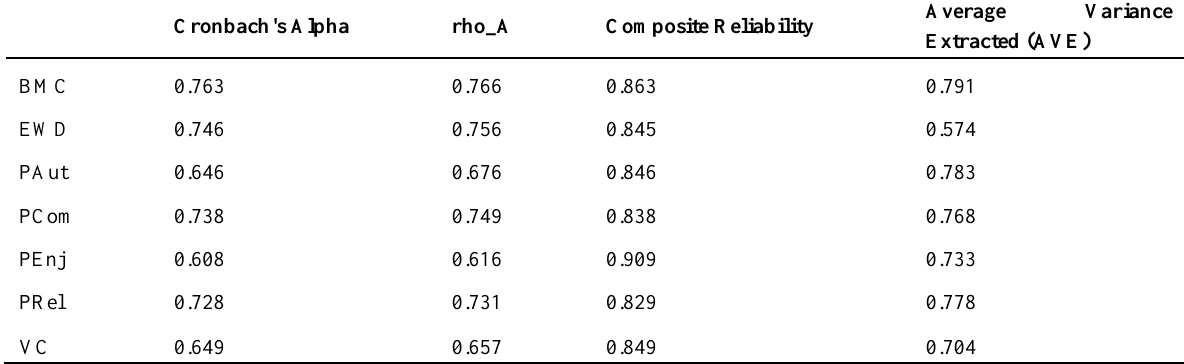
Table 1 : Analysis of Convergent Validity